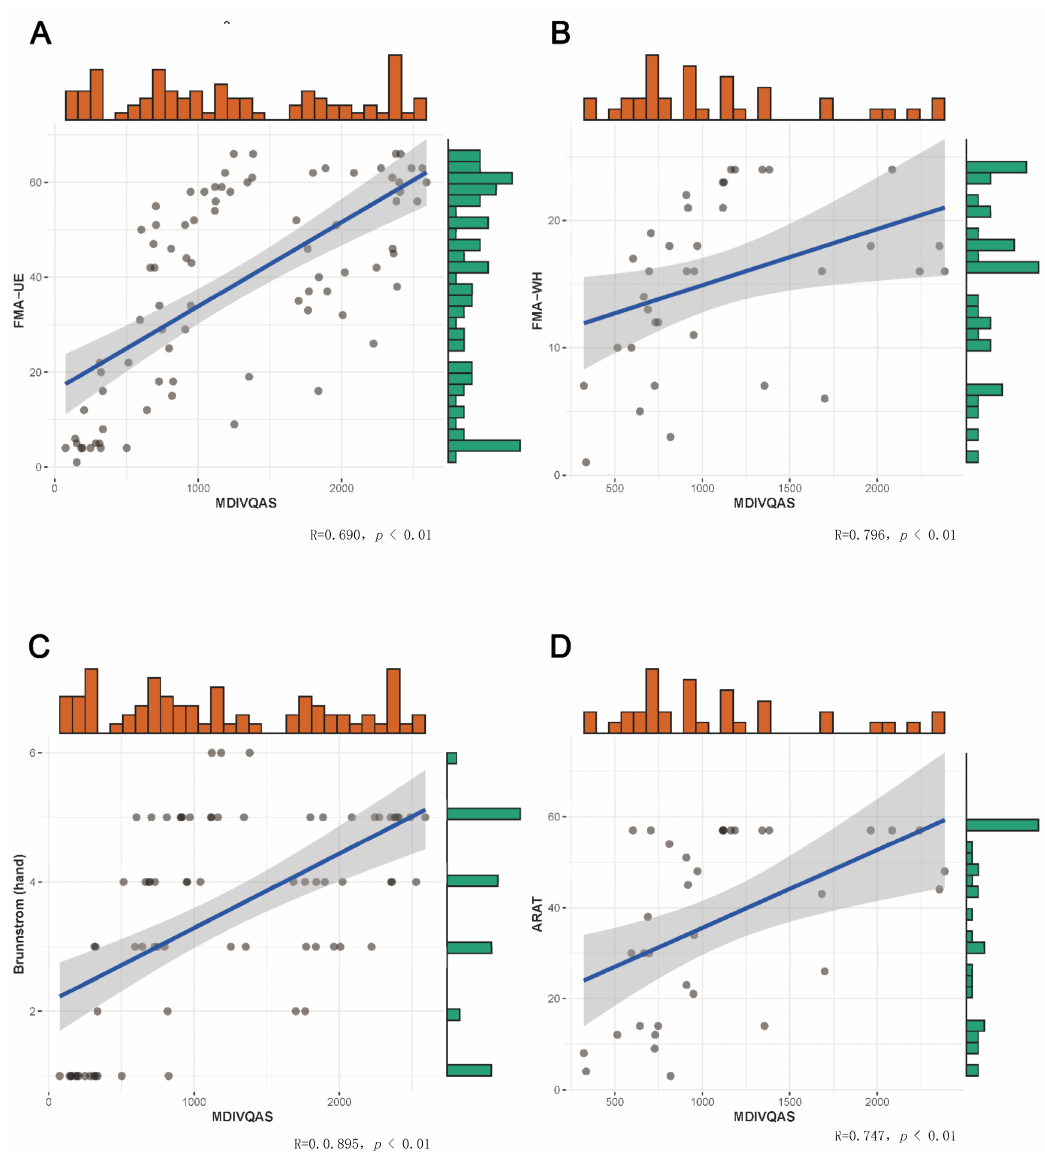
Figure 6. Correlation between MDIVQAS, FMA-W/H, Brunnstrom (hand) and ARAT. ( A ) Cor- relation between MDIVQAS and FMA-UE. ( B ) Correlation between MDIVQAS and FMA-W/H. ( C ) Correlation between MDIVQAS and Brunnstrom (hand). ( D ) Correlation between MDIVQAS and